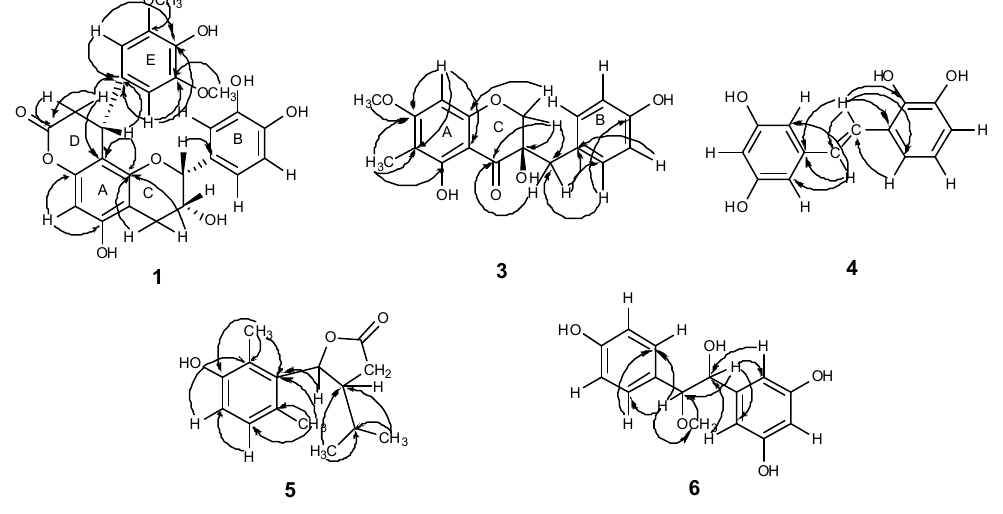
Figure 3. Main HMBC correlations of compounds 1 , 3 – 6